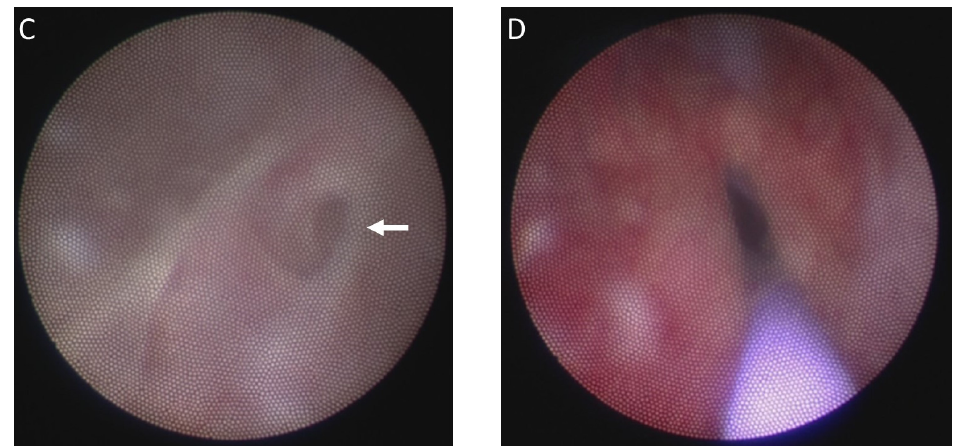
Figure 2. ( A ) Dilated opening of the utricle (arrow). ( B ) A cystoscope was inserted into the dilated prostatic utricle. ( C ) Left-sided dilated opening of the ejaculatory duct (arrow). ( D ) Guidewire was inserted into the utricle for further identification under laparoscopic surgery.